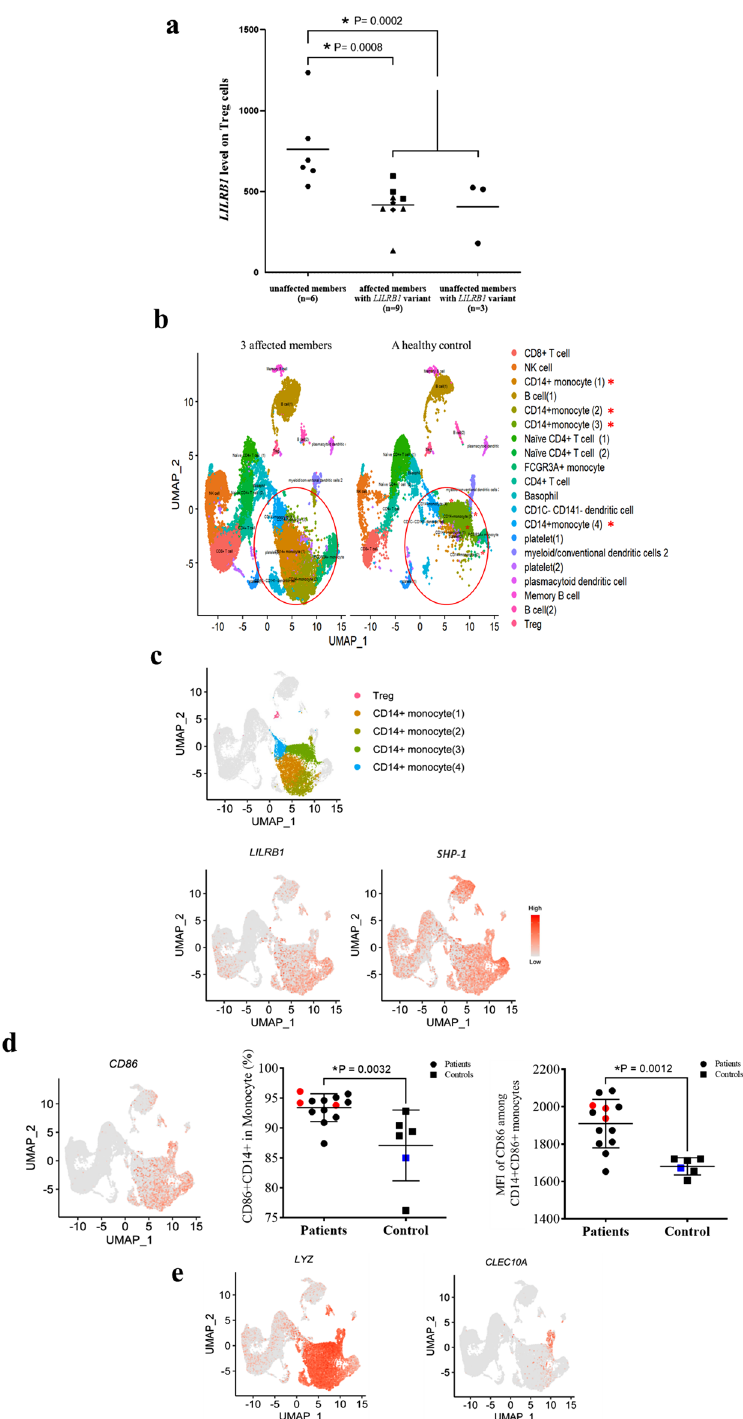
Figure 3. Flow cytometry and single cell RNA sequencing (scRNA-seq) results. (a) Comparison of mean fluorescent intensity (MFI) of LILRB1 expression on the surface of activated Treg cells in family members ( b ) High-dimensional transcriptomic scRNA-seq clustering reveals increased percentage of monocyte subsets in the three studied patients compared with the sex-, age- and ethnic-matched control. ( c ) Two-dimensional UMAP visualization of PBMCs of patients with the LILRB1 variant. Colors represent four clusters (cell types) of interest similar to ( b) (top panel). Expression of marker genes for LILRB1 and SHP-1 (bottom panel). Red color indicates high expression level of the gene. (d) UMAP visualization of PBMCs of patients with the macrophage subset markers CD86 (left panel) and flow cytometry results of the frequency (middle panel) and MFI (right) of CD86 marker, where red and blue dots indicate samples of patients and controls concurrently investigated in scRNA- seq experiment, respectively. * indicates statistical significance. (e) LYZ (left panel) and CLEC10A (right panel) expression in cell population . Visualization of single-cell transcriptome data was done in R (v. 4.2.1; https:// www.R- proje ct. org) using RStudio (http:// www. rstud io. com) and R packages tidyverse (v. 1.3.1; https:// doi. org/ 10. 21105/ joss. 01686) and ggpubr (v. 0.4.0; https:// CRAN.R- proje ct. org/ packa ge=